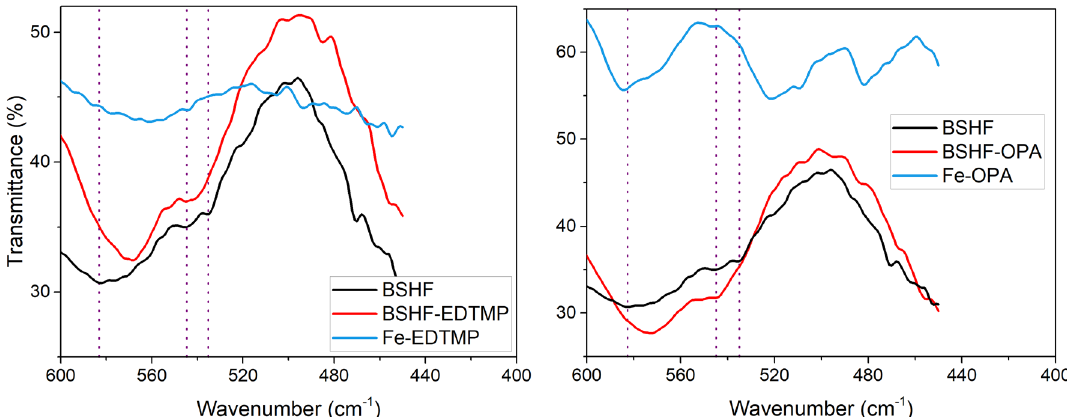
Figure 5. DRIFT spectra of the core and coated BSHF NPLs and of the Fe-complexes. The dotted lines represent typical Fe–O vibration bands in the core BSHF